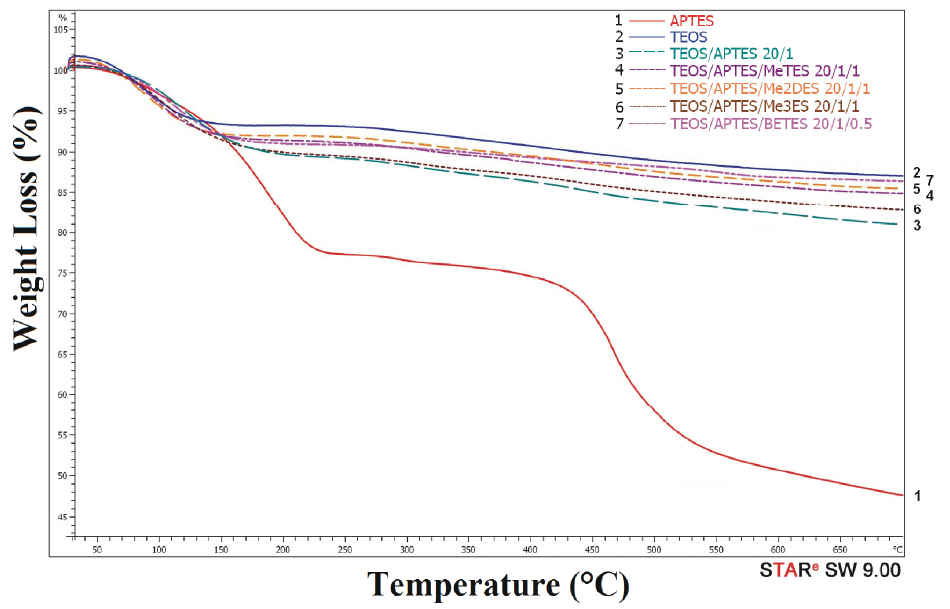
Figure 1. Thermogravimetric (TG) curves of aminopropyl ‐ silica particles.